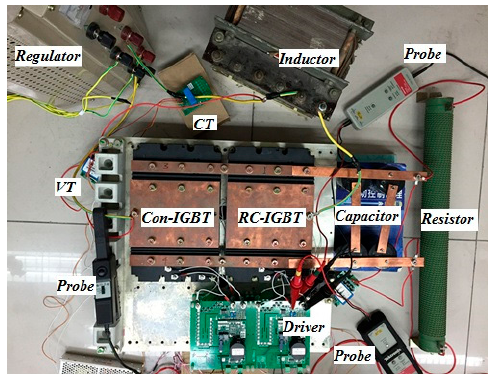
Figure 14. Test platform for RC-IGBT PWM convertor.